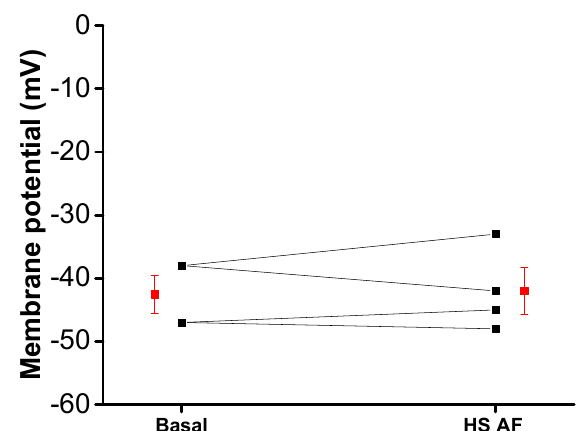
Figure 8. Effect of HS AF 2 mg/mL on the membrane potential of Wistar rat MA rings: individual (black) values and mean ± SEM (red) (n = 4/4).